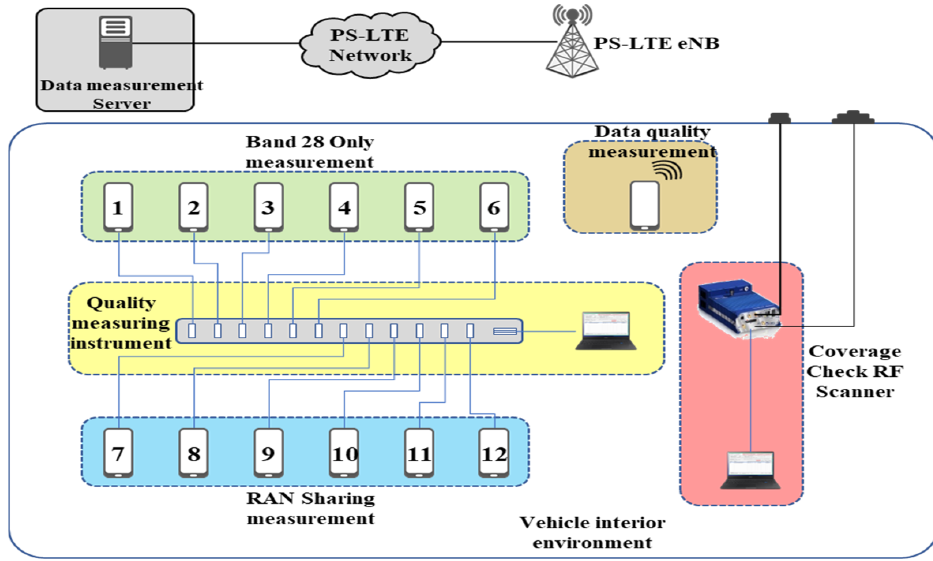
Figure 9. Block diagram of measuring environment for coverage and quality.